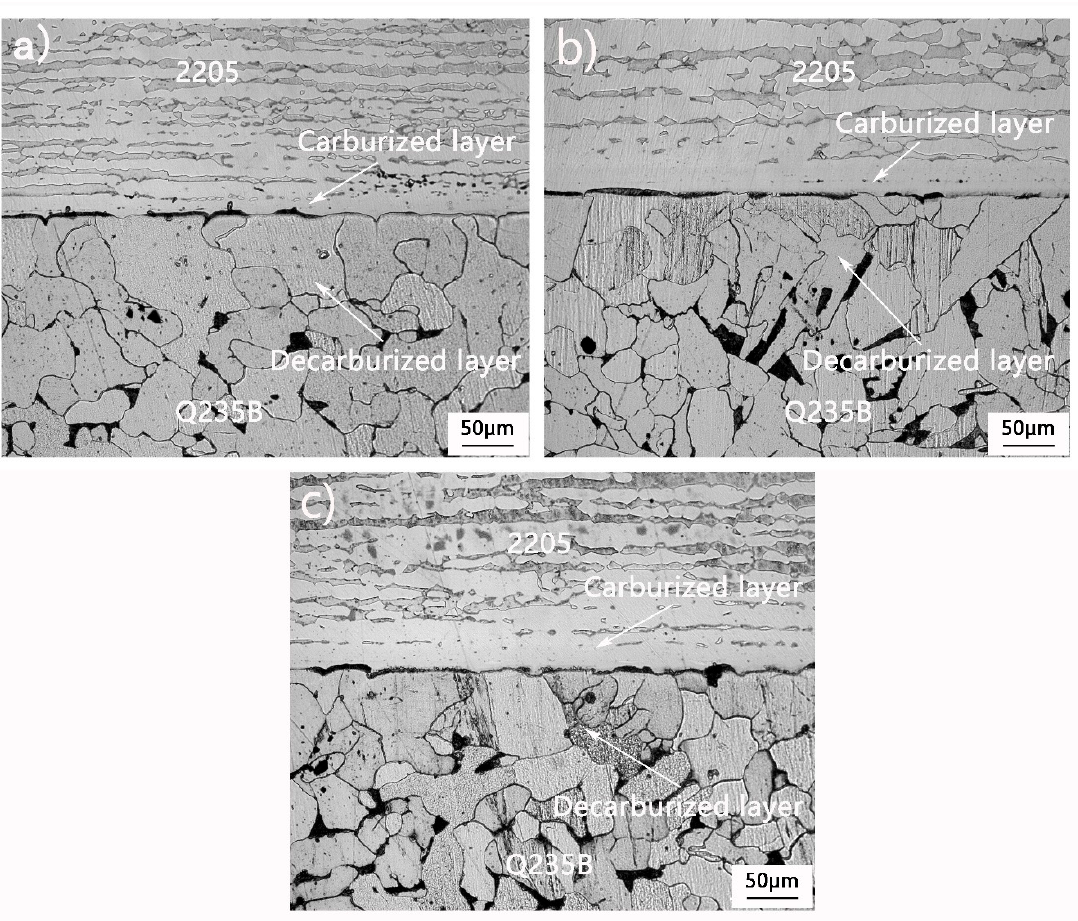
Figure 1. Microstructure of the cross section of a 2205/Q235B composite plate at different heating temperatures: ( a ) 1100 ◦ C, ( b ) 1150 ◦ C, and ( c ) 1200 ◦ C.